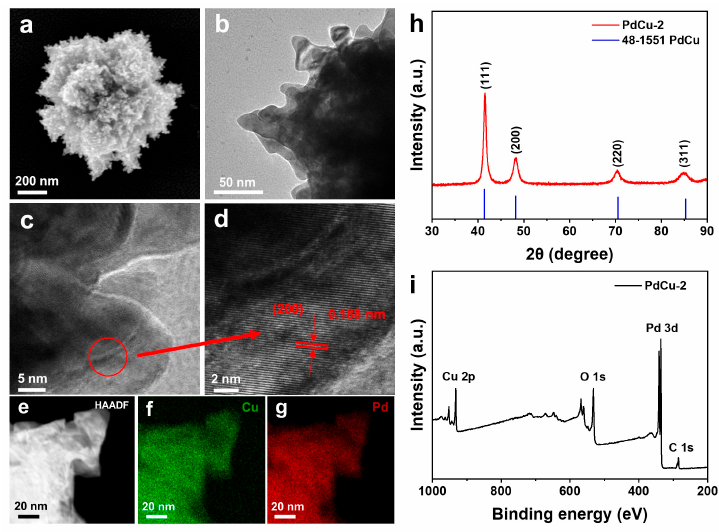
Figure 1. Characterization of PdCu − 2: ( a ) SEM image of PdCu − 2; ( b ) TEM image of PdCu − 2; ( c ) and ( d ) HRTEM images of PdCu − 2; ( e – g ) Elemental mapping images of Pd and Cu of PdCu − 2; ( h ) XRD pattern of PdCu − 2; ( i ) The full survey XPS spectrum of PdCu − 2.